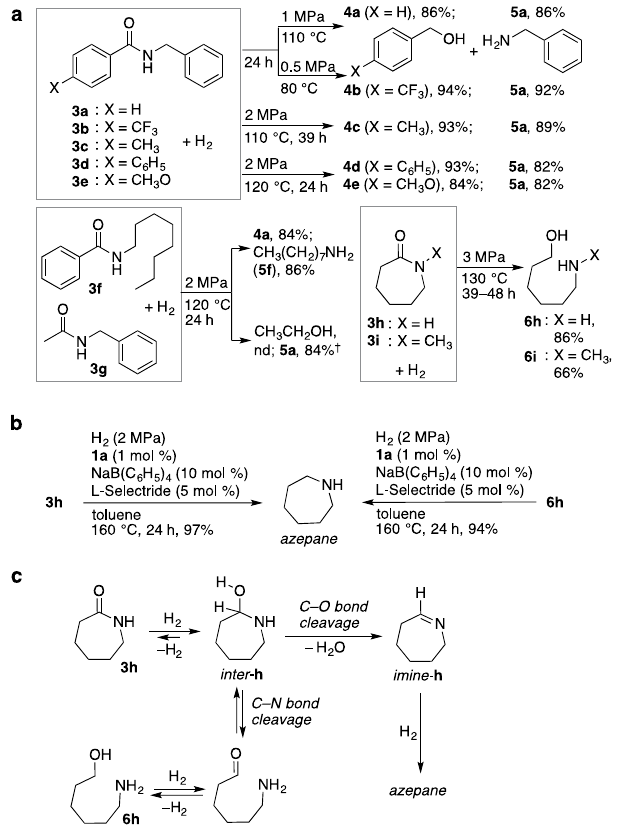
Figure 3. Hydrogenation of aromatic and cyclic amides. Unless otherwise specified, the reaction was performed using 1a (1 mol %), 3 (100 mol%), and NaH (6–10 mol %) in toluene. Pressure indicated is of H 2 at 25 °C. nd: not determined. See Supplementary Information for experimental details. ( a ) Hydrogenation with P H2 = 0.5–3 MPa, T = 80–130 °C. ( b ) Additive effects on selective C = O bond cleavage in the hydrogenation of a cyclic amide and in the dehydrogenation/hydrogenation of a linear amino alcohol. ( c ) Possible reaction pathways starting from 3h and 6h under hydrogenation conditions. † 1a was preactivated: P H2(pre) = 1 MPa, T pre = 160 °C, t pre = 5